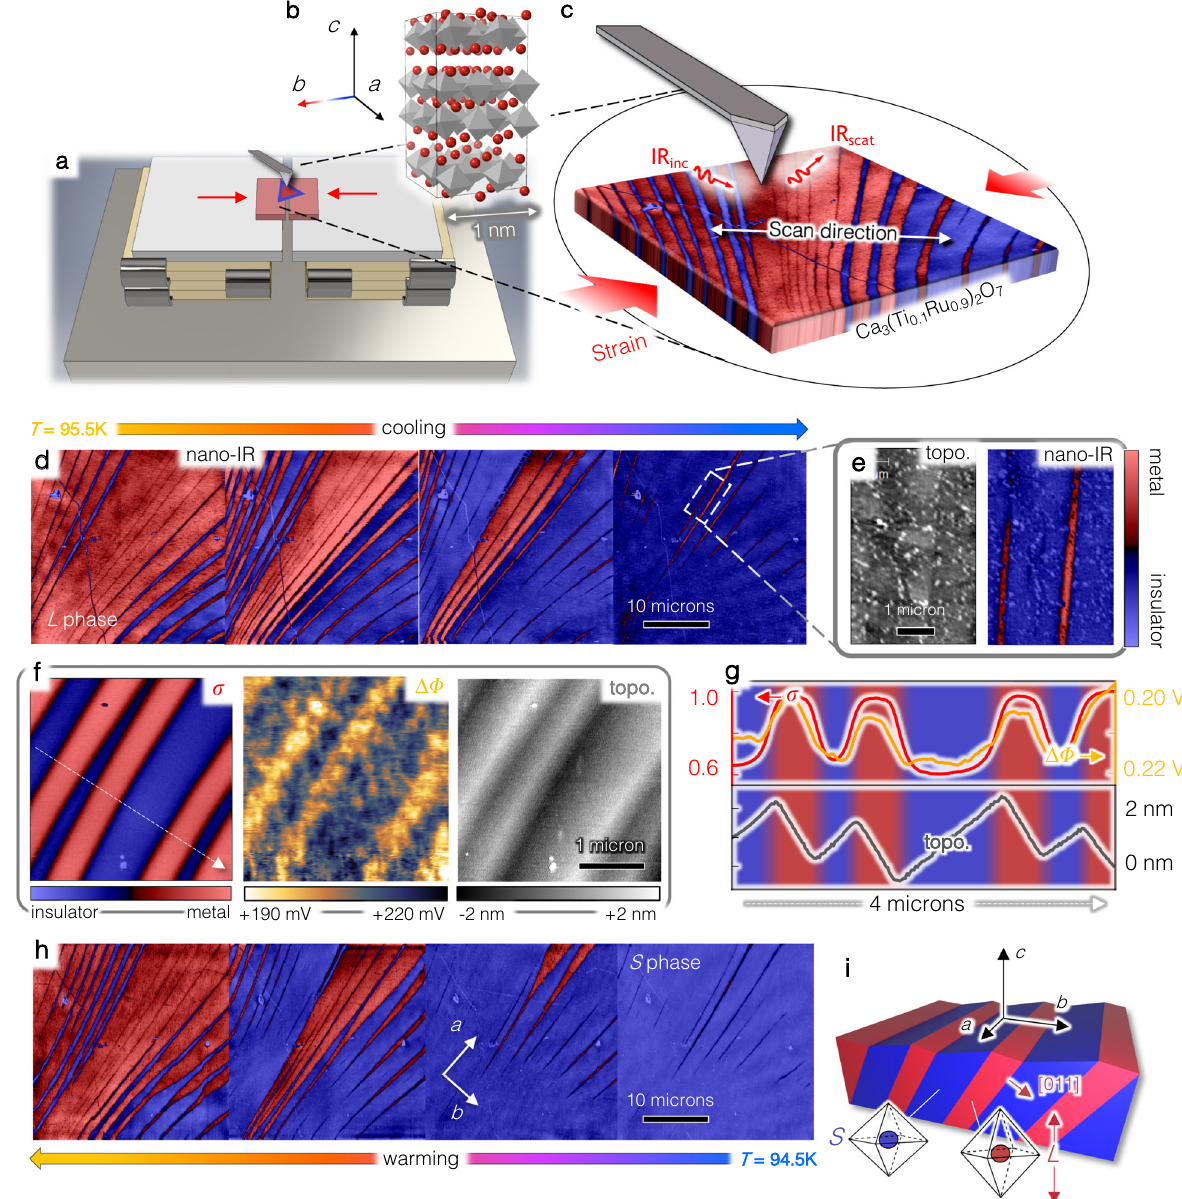
Fig. 1 Mott nano-textures in a bilayer ruthenate. a Schematic depiction of a 100 micron-scale thin Ca 3 (Ti 0.1 Ru 0.9 ) 2 O 7 crystal mounted to a home-built strain stage inside the low-temperature nanoscope. b Crystal structure of the bilayer ruthenate; our experiments apply uniaxial strain within 30 degrees of the crystallographic b-axis. c Metal/insulator nano-textures are detected by nano-imaging the crystal surface ( ab- plane) at 100 meV probing energy during in situ application of strain. d Striped nanotextures emerging while cooling the crystal from the metallic L phase through the Mott transition from T = 95.5 K to 94.5 K without applied external strain; images shown were acquired at (cid:1) 0.3 K intervals. e Minority phases take the form of acicular domains; topography shares color scale with f . f Correlative topography, contact potential difference ΔΦ (see text) and nano-IR signal σ recorded across of a series of L phase domains; the color-scale for σ indicates the nano-IR response from the insulating phase is 30% that of the metal. g Correlative line-pro fi les along the arrow in ( f ) associated with each imaging channel; the surface work function anticorrelates local metallicity, and expansion of L domains buckles the surface topography. h Same region as ( d ) imaged while warming from the insulating L phase; images shown were acquired at (cid:1) 0.3 K intervals. i Inferred schematic structure of coexisting L and S domains ([011] habit plane) showing associated RuO 6 octahedral